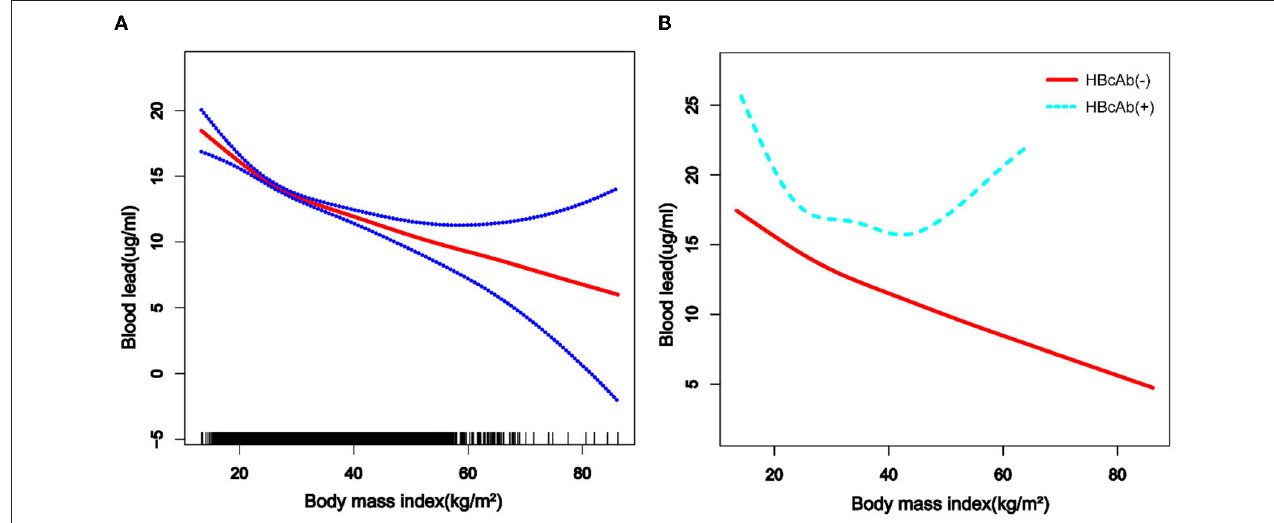
FIGURE 2 | The association between BMI and blood lead levels. (A) The solid rad line represents the smooth curve fit between variables and a dotted line represents the 95% CI from the fit. All the covariates in the study and HBcAb were adjusted except body mass index (BMI). (B) The solid rad line represents HBcAb (–) and the dotted line represents HBcAb ( + ). All the covariates in the study are adjusted.